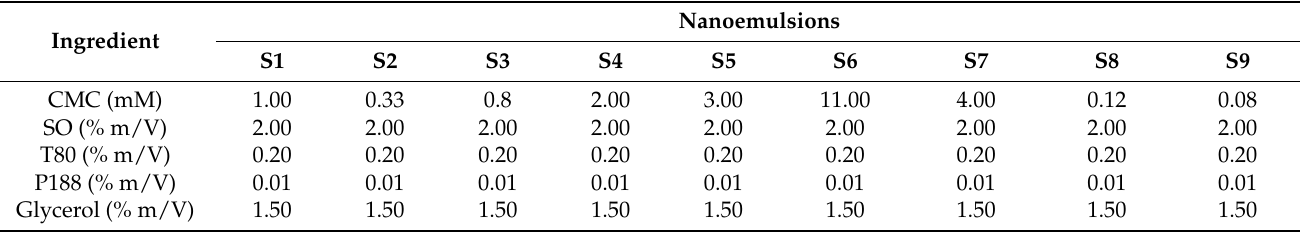
Table 1. Composition of the developed